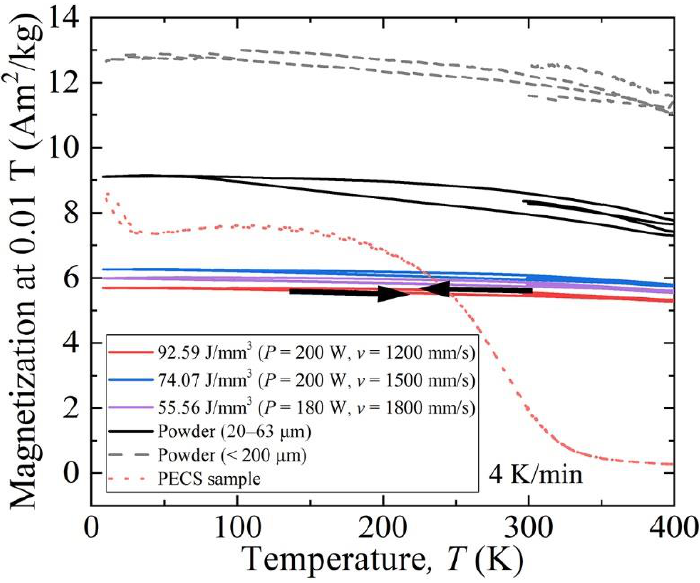
Figure 14. Temperature dependence of magnetization curves in the range of 10 to 400 K for original powder, as-built AlCoCr 0.75 Cu 0.5 FeNi specimens, and reference PECS sample. In order to determine ferromagnetic Curie point T c , one of the LPBF samples fabricated with the VED of 74.07 J/mm 3 (laser power of 200 W and scanning speed of 1500 mm/s) was further heated in a low magnetic field (0.01 T) up to the temperature of 800 K and held there for 10 min. The evolution of the low field and saturation magnetization in the range from 10 to 800 K is shown in Figure 15a. After first heating, the M s at 2 T and 305 K increased approximately by 10 Am 2 /kg. The magnetization did not change in the second heating in the magnetic transition occurs at the temperature of about 580 K. Further heating results in increase at 800 K. Differential scanning calorimetry (DSC) curve of spray-cast equiatomic AlCoCrCuFeNi alloy indicates no phase transition in this region [29], thus, the observed magnetization behavior indicates some magnetic transition(s) which is likely of second order. Furthermore, another sample produced by the VED of 55.56 J/mm 3 (laser power of 180 W and scanning speed of 1800 mm/s) is heated in the field of 2 T and held at 800 K for 10 min in the first heating round, as depicted in Figure 15b. M s is increased by nearly 15 Am 2 /kg after the first heating, and it remains almost unchanged in the second round of heating to 800 K. As the temperature further rises to 1000 K in the third heating round, the decrease of M s is noticed. During the cooling process in the third round, three kinks are observed, as marked with dotted lines in Figure 15b, which indicates the formation of three different phases. Previously, the degeneration of spinodal decomposition structures in spray-cast equiatomic AlCoCrCuFeNi alloy was found to occur at 913 K [29]. Therefore, it is likely that the disappearance of A2 and B2 phase, as well as the formation of a new phase, is initiated after heating up to 1000